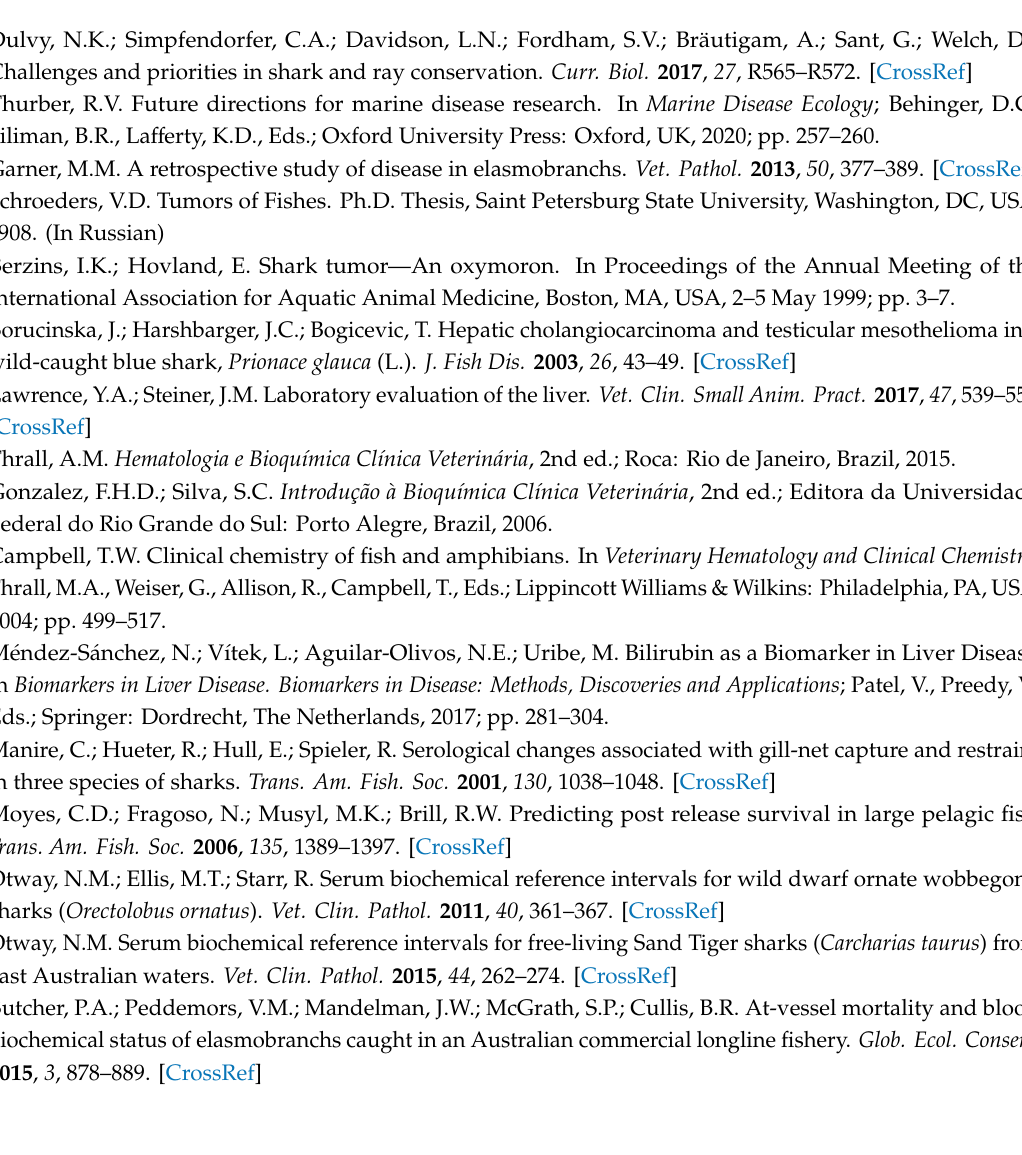
Table S1: Serum physiological markers analyzed in the present